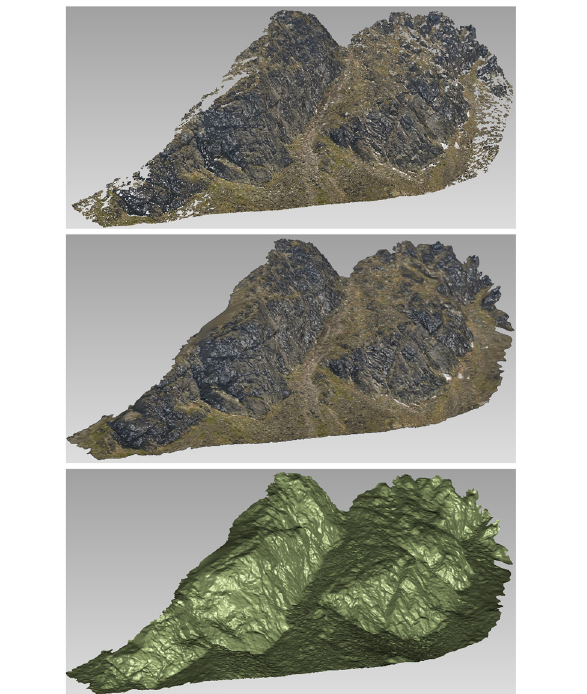
Figure 6. Ko ś cielec walls visualized as an RGB point cloud, photo-textured mesh and NURBS